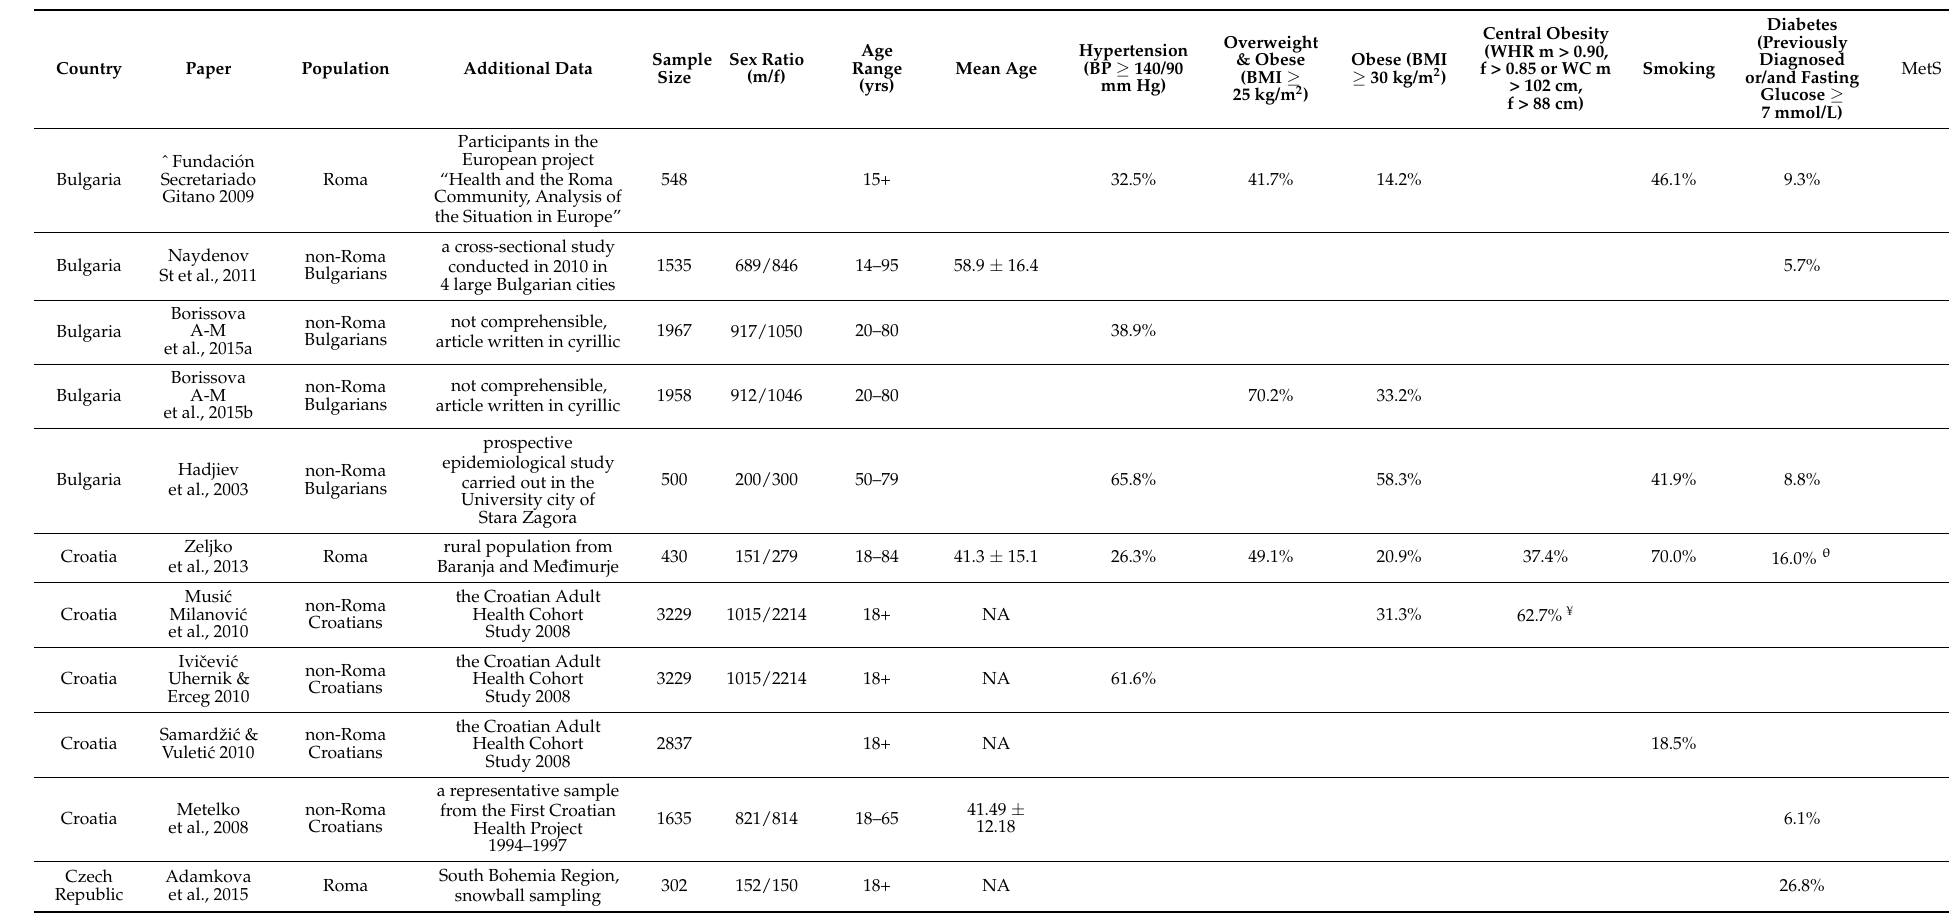
Table 1. Characteristics of 52 studies included in the meta-analysis presented by countries. Age data in this table are not presented uniformly because they were reported differently in the papers: some authors preferred age range, others mean age (SD) or just reported that subjects were over a certain age. We divided subjects from each of the 16 countries in two population groups: group one were Roma, while group two were non-Roma. Each study group consisted of both females and males. Each of the investigated CVD risk factors is presented as a prevalence (percentage) and not in absolute numbers. Complete references of these studies are given in the Supplementary